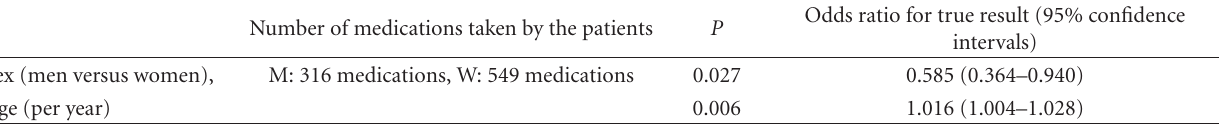
Table 2: Influence of patient age and sex on the performance of the IFN-gamma release test. Number of medications taken by the patients